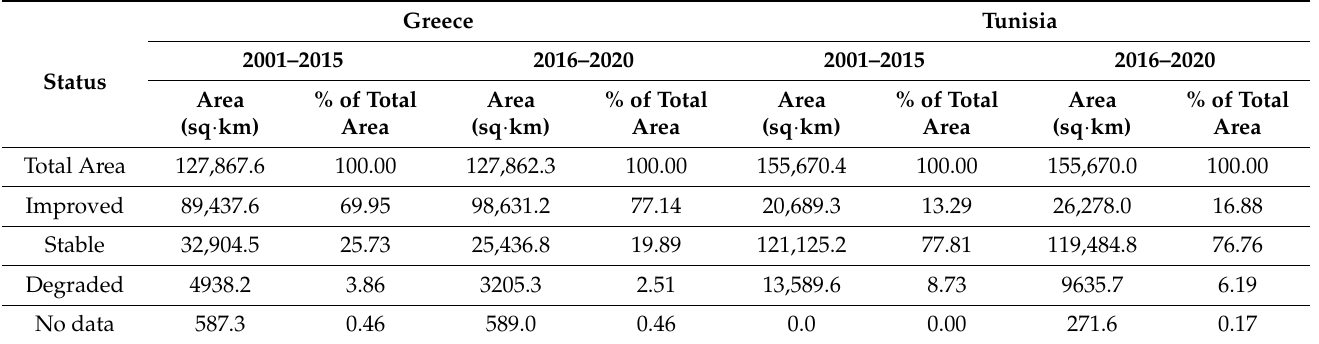
Table 2. Land productivity metrics for the baseline and reporting periods in Greece and Tunisia.